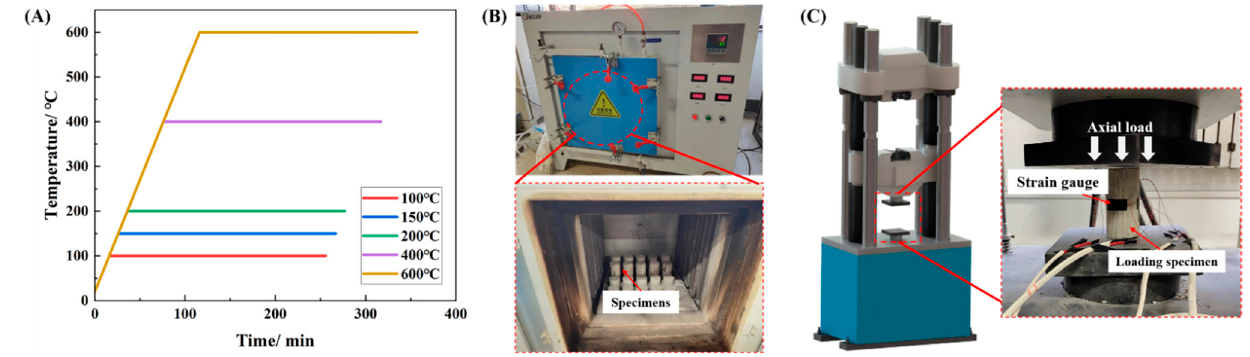
Figure 3. Temperature rise curve ( A ), high temperature treatment equipment ( B ) and test device for uniaxial compression ( C